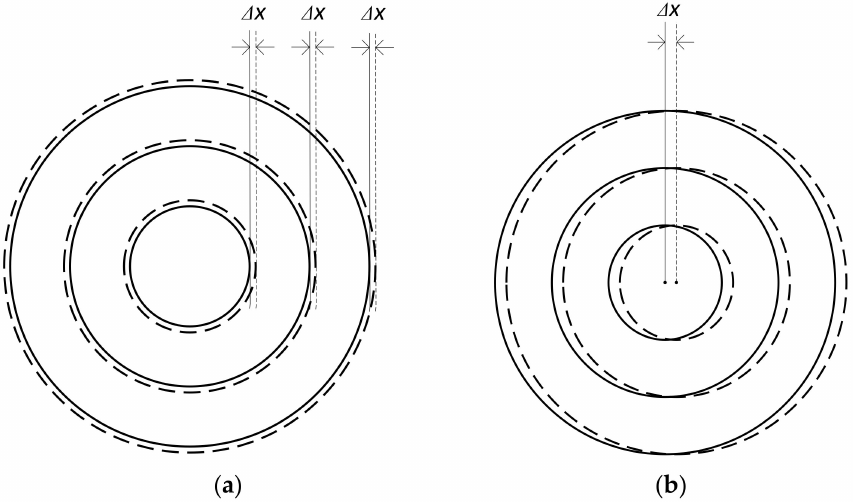
Figure 11. Types of scanning errors. ( a ) The first kind of scanning error, homogeneous radius error caused by the deviation of the starting position; ( b ) The second kind of scanning error, center shift between the planned and actual scanning